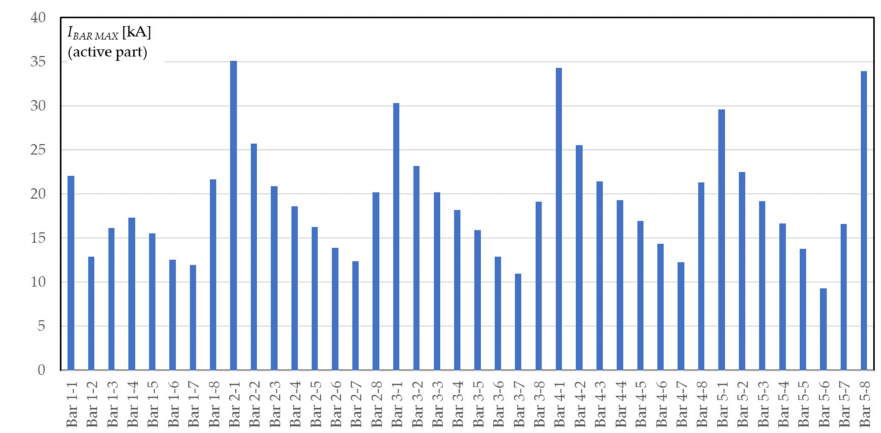
Figure 17. Distribution of maximum values of currents induced in the active part of the rotor bar during out-of-phase synchronization of − 120 ◦ .